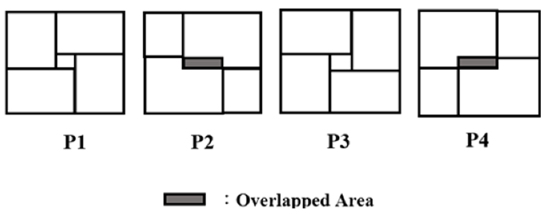
Figure 3. Object arrangement